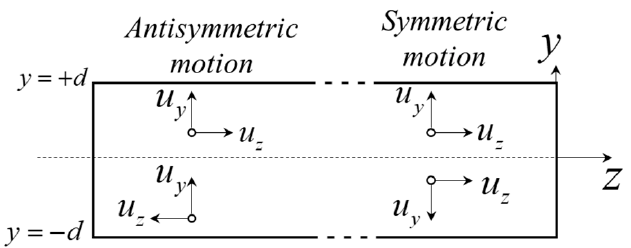
Figure 4. Symmetric and antisymmetric particle motion across the plate thickness.